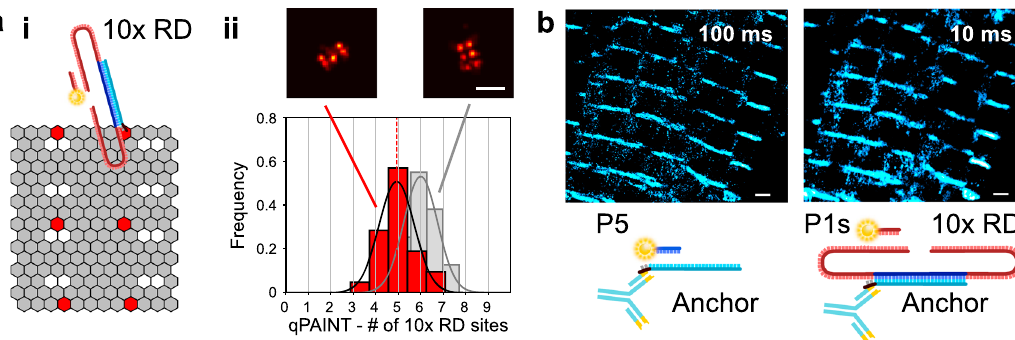
Fig. 6 Repeat DNA-PAINT is compatible with qPAINT and increases imaging rate. a i Scheme of the origami test tile used for qPAINT experiments. Due to natural self-assembly inaccuracy, not all tiles feature 6 detectable docking sites. ii Distribution of the number of docking sites determined from qPAINT in tiles featuring 5 detectable sites (red). The median of the histogram is 4.93 ± 0.16 sites/tile. The gray histogram indicates qPAINT results for tiles with 6 sites, used for calibration. Above: rendered images of representative tiles. b Rendered DNA-PAINT images of alpha actinin in cardiac tissue as imaged with regular DNA-PAINT (1x RD) at low frame-rate (100 ms/frame, left), and Repeat DNA-PAINT (10x RD) at high frame-rate (10 ms/frame, right), showing similar results. The overall image acquisition time was 2000 s for 1x RD and 1600 s for 10x RD (Supplementary Fig. 8). Samples with 1x RD were imaged with 9 nt P5 imagers. Shorter (8 nt) imagers were used with 10x RD to achieve brief binding times and avoid spatiotemporal overlap of the blinks (see also Supplementary Note 1). In both cases, we used [ I ] ~0.3 nM. Scale bars: a 100 nm, b 1 µ